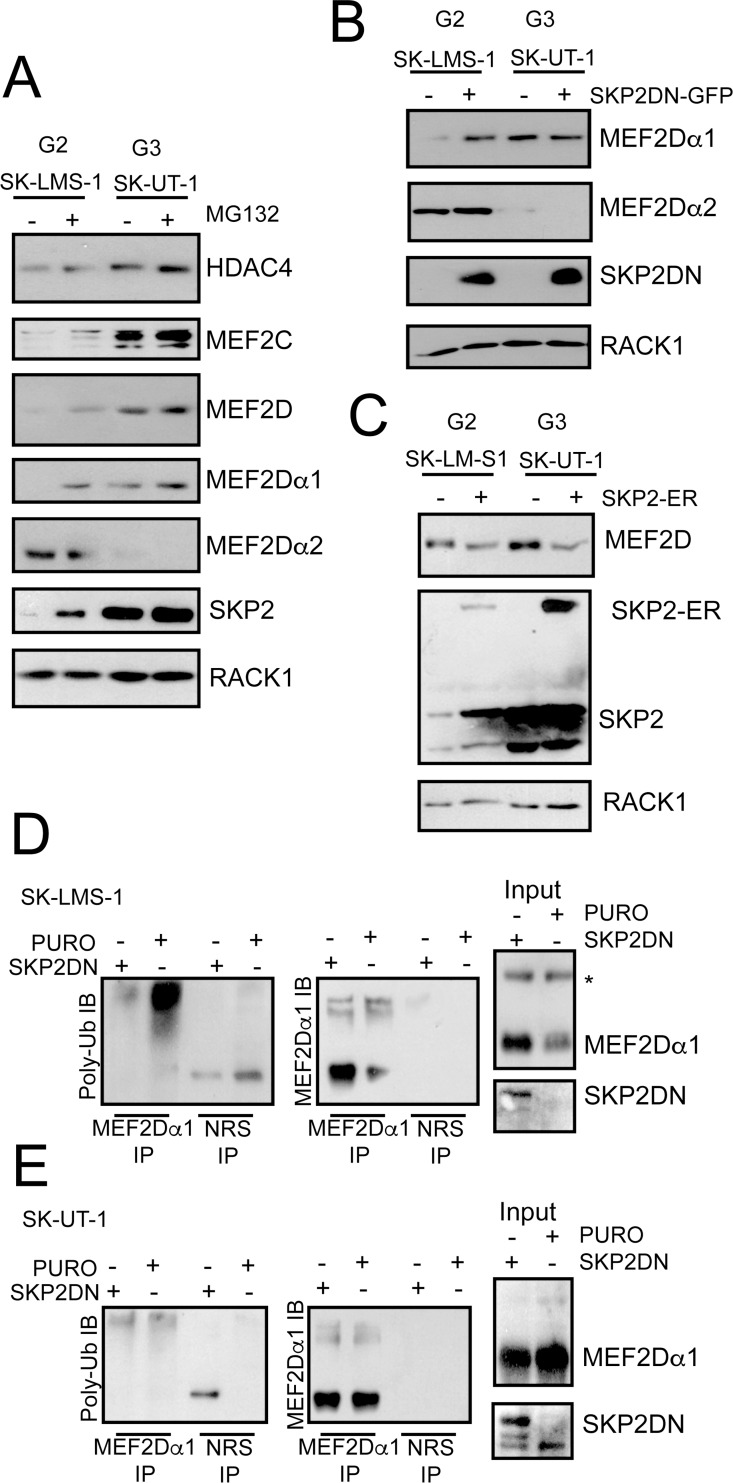
Defect in UPS-mediated MEF2-degradation in the most aggressive LMS cell line.A) Immunoblot analysis of HDAC4, SKP2 and MEF2 family members in LMS cells. Cells were treated for 8 hours with 2.5μM of the UPS inhibitor MG132. RACK1 was used as loading control. B) Immunoblot analysis of MEF2D isoforms in LMS cells engineered to express the dominant negative version of SKP2 (DN). RACK1 was used as loading control. C) Immunoblot analysis of MEF2D in LMS cells engineered to express an inducible version of SKP2 fused to ER as indicated. SKP2 was induced for 30 hours with 0.5μM 4-OHT. RACK1 was used as loading control and the nuclear relocalization of SKP2 after 4-OHT treatment was scored by immunofluorescence. D) Cellular lysates obtained in SK-LMS-1 cells expressing the DN mutant of SKP2 were immunoprecipitated using anti-MEF2Dα1 antibody and immunoblotted with the indicated antibodies. Immunoblots with total lysates (input) are also included. E) Cellular lysates obtained in SK-UT-1 cells expressing the DN mutant of SKP2 were immunoprecipitated using anti-MEF2Dα1 isoform and immunoblotted with the indicated antibodies. Immunoblots with total lysates (input) using the indicated antibodies are also included.